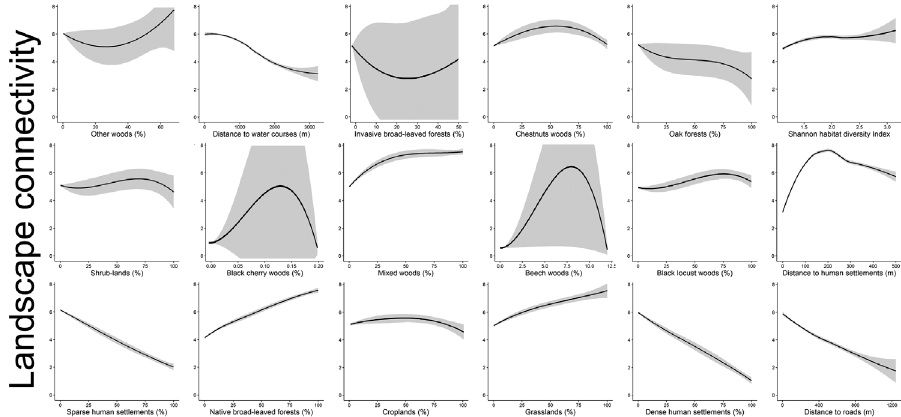
Figure 4. Response curves and 95% confidence intervals (in grey) of landscape connectivity of the stag beetle estimated through Circuitscape in relation to predictor variables values.